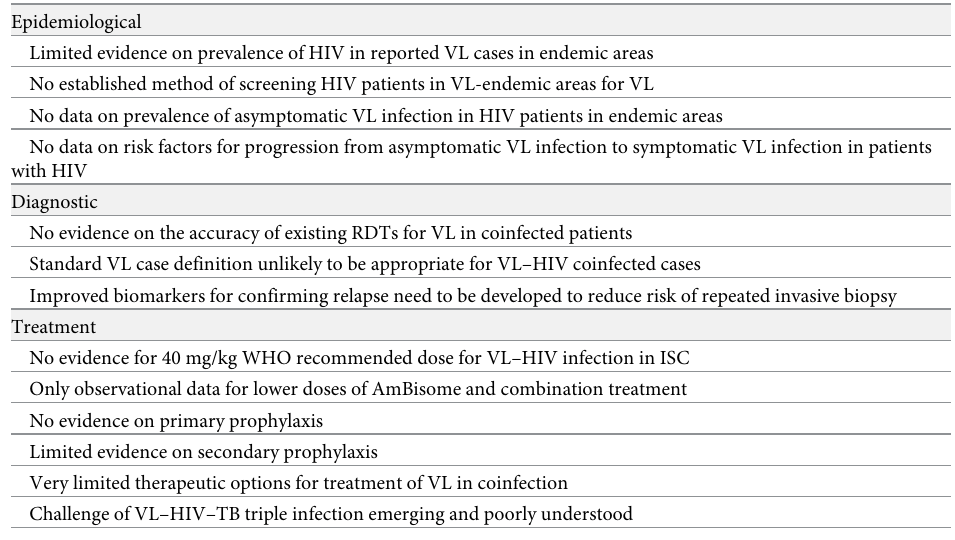
been reported in the Mediterranean Basin, particularly in Spain, which is among the foremost in performing SOTs and is endemic for L . infantum transmission. In these patients, the immunosup- pressive therapy to avoid graft rejection affects T cell lymphocytes, altering the mechanisms of defence against intracellular microorganisms as Leishmania , predisposing to manifestations of disease. However, the precise mechanism behind the VL risk has not been well defined. The development of VL by SOT recipients is not related to the origin of the organ, the socioeconomic category of the patient, nor the type of transplant, although usually associated with renal transplants as they are the most frequent transplant (Table 4). It is much more